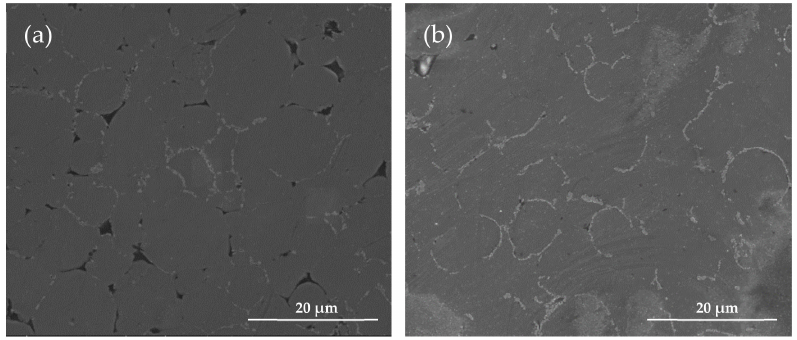
Figure 14. Specimen sintered at 620 ◦ C for ( a ) 4 h and ( b ) 8